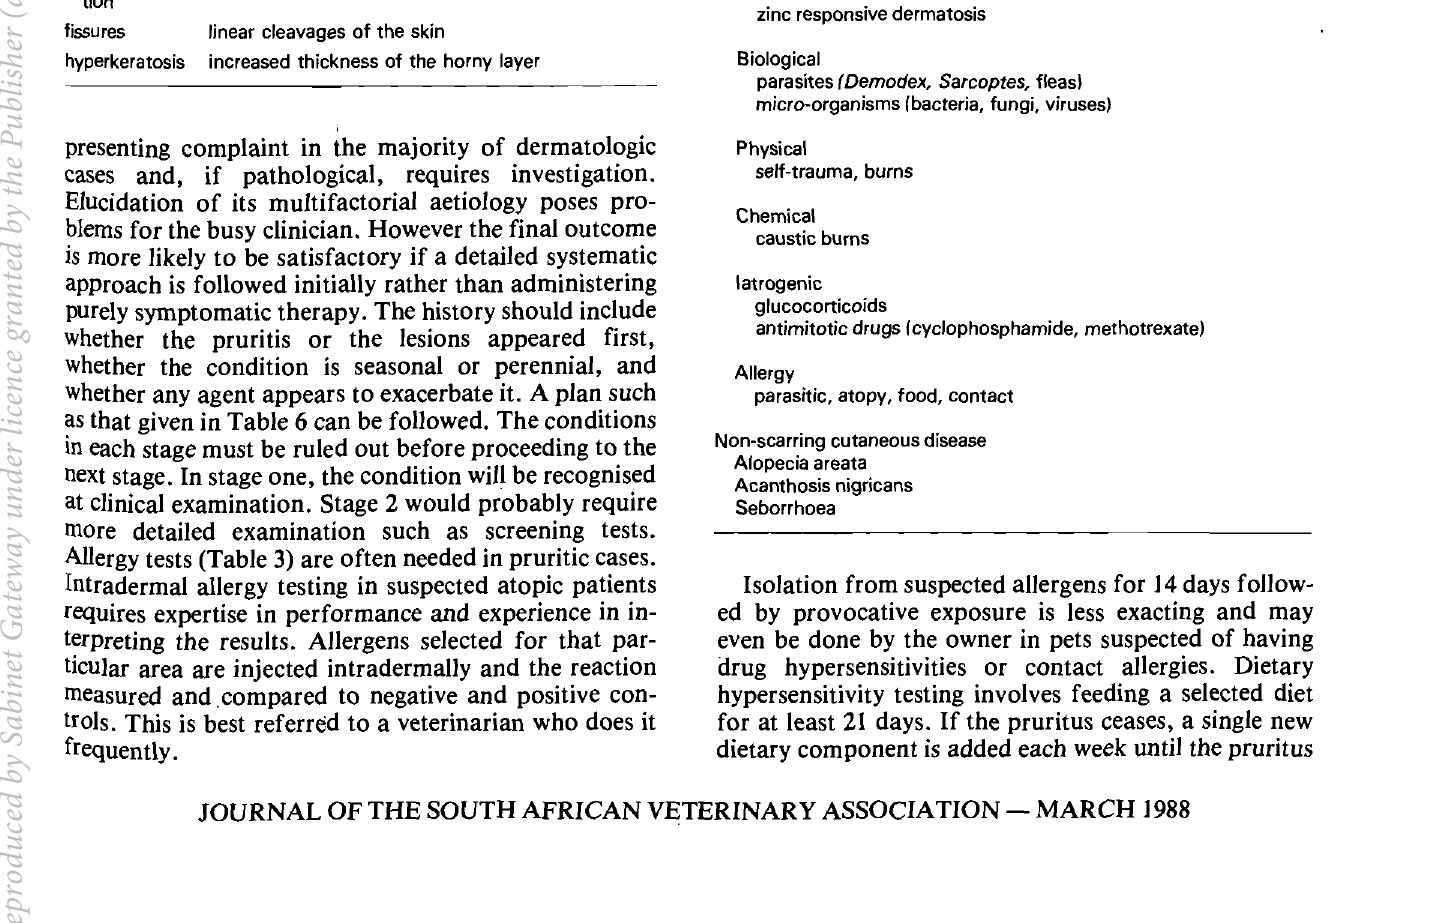
Table 5: Secondary lesions